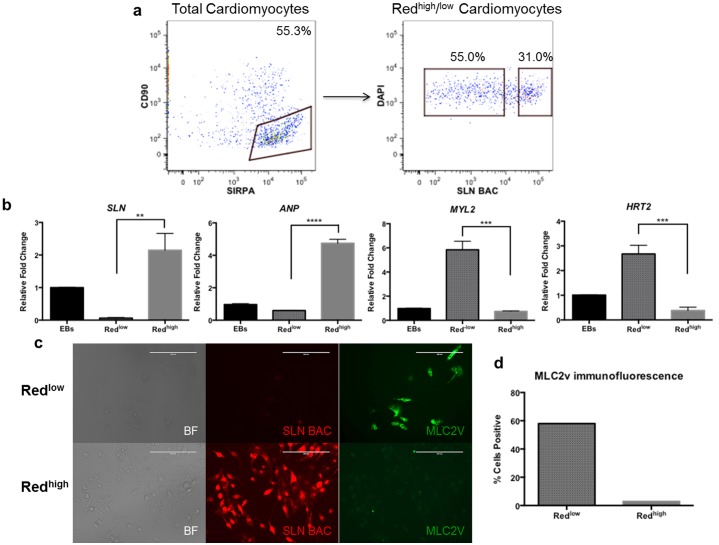
Purification and characterization of redhigh and redlow cells.(a) Cell sorting strategy to purify redhigh and redlow cardiomyocytes. Cells were first gated on the total cardiomyocyte population, marked as SIRPα+/CD90−, and then purified based on high or low levels of red fluorescence. (b) qPCR for relevant atrial (SLN, ANP) and ventricular (MYL2, HRT2) genes in purified redhigh (n = 3) and redlow (n = 3) populations. (**p<0.01, ***p<0.001, ****p<0.0001). (c) Immunofluorescence for MLC2v showing exclusive expression in redlow population. Scale bars, 200 µm. (d) Quantification of fraction redlow (n = 143) and redhigh (n = 514) cells expressing MLC2v protein from (c).